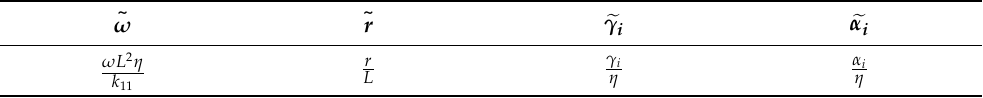
Table 1. Non-dimensionalized variables for Couette